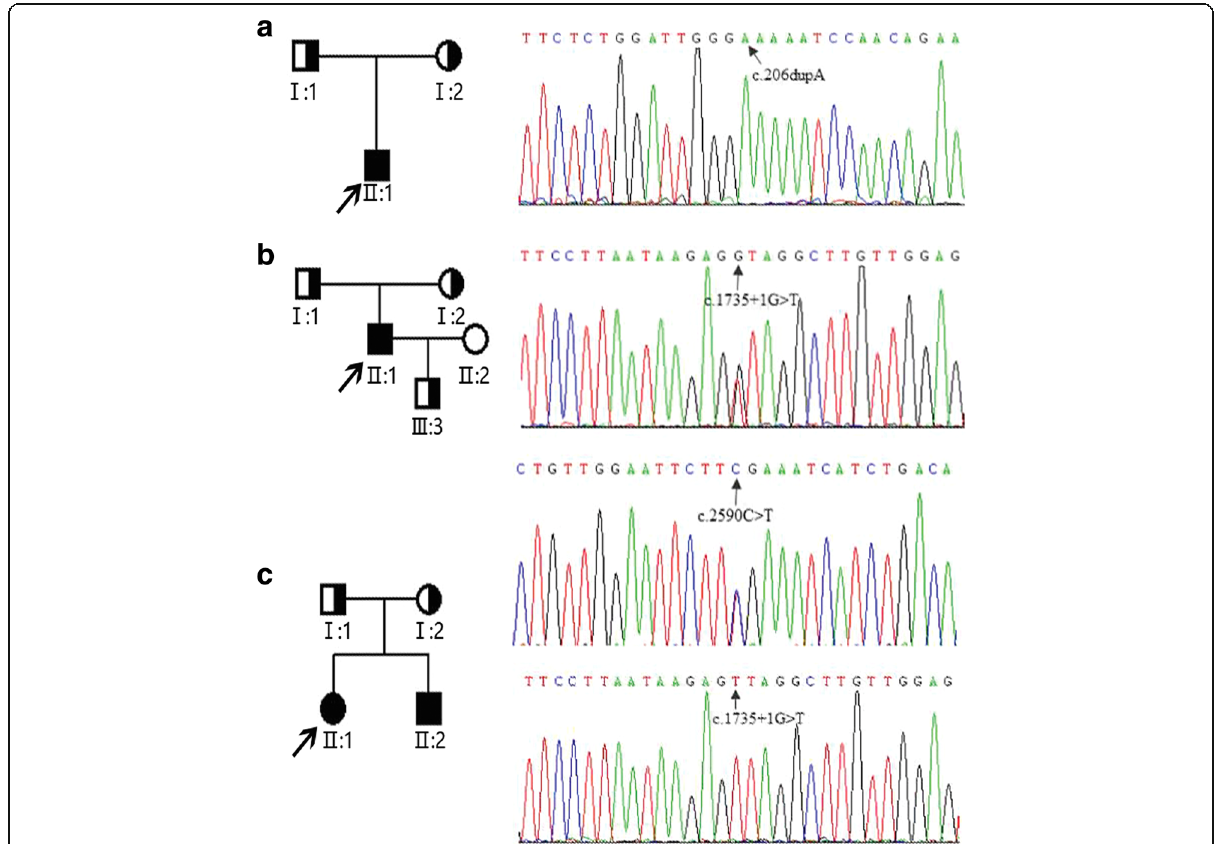
Fig. 2 Pedigrees of our patients with GSD IIIa and mutation analysis of AGL gene. Filled circles and squares represent affected females and males, respectively. Proband is indicated with an arrow; a . patient 1 (II:1) from family 1. The DNA sequence chromatogram of the proband indicates AGL c.206dupA homozygous mutation indicated with an arrow; b . patient 2 (II:1) from family 2. The DNA sequence chromatogram of the proband indicates AGL c.1735+1G>T homozygous mutation with an arrow; c . patient 3 (II:1) and patient 4 (II:2) from family 3. The DNA sequence chromatogram of the proband indicates AGL C.1735+1G>T and AGL c.2590 C>T compound heterozygous mutations indicated with Additional file 1: Table S1. There was fifteen male and